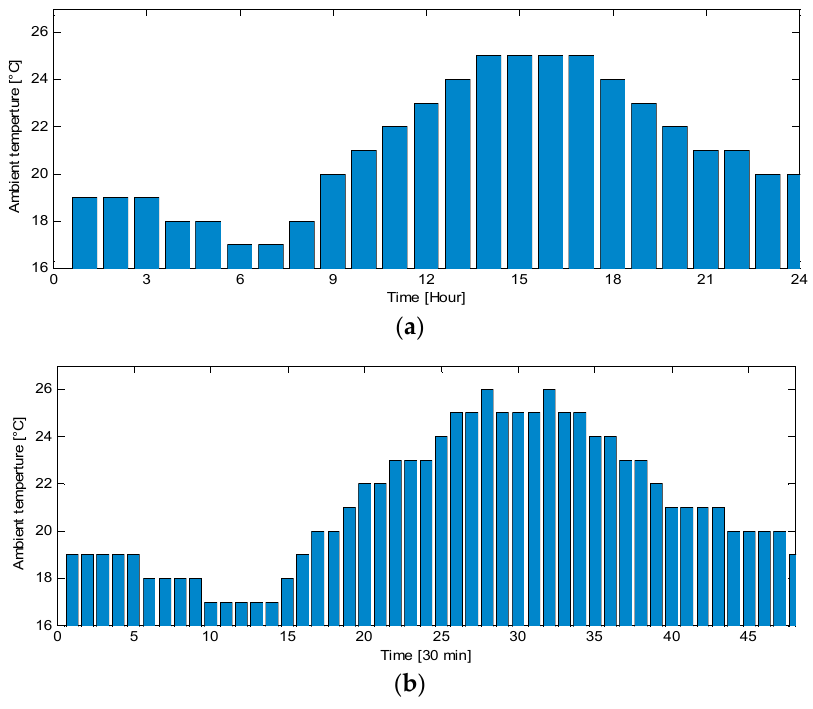
Figure 3. temperature data. ( a ) Hourly average time. ( b ) 30 min average time.